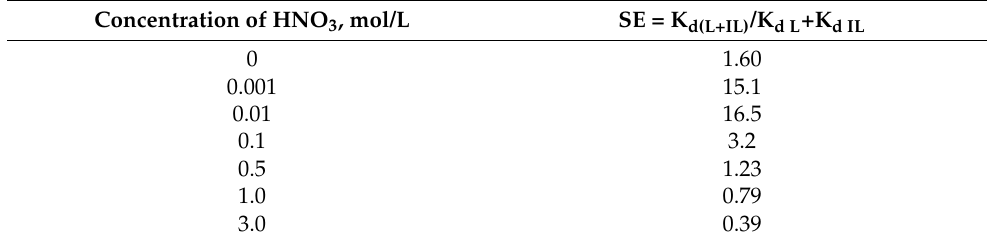
Table 1. The values of synergy effect (SE) of Nd(III) recovery by SIR 4 for various concentrations of HNO 3 .